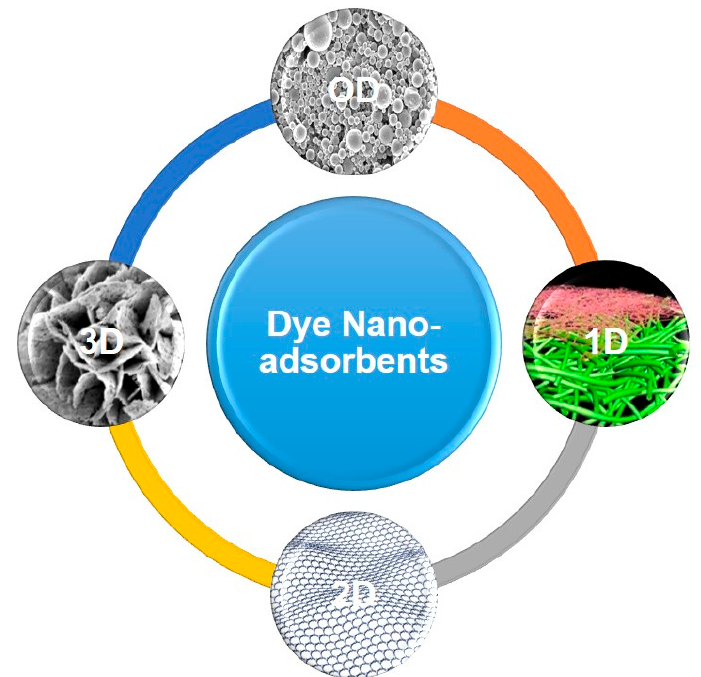
Figure 2. Various classes of the dye nano-adsorbents from the dimensionality standpoint. The used images for 0D, 1D, and 3D nano-adsorbents were reproduced with permission [25–27], respectively. The image related to the 2D nano-adsorbent was under a CC license.